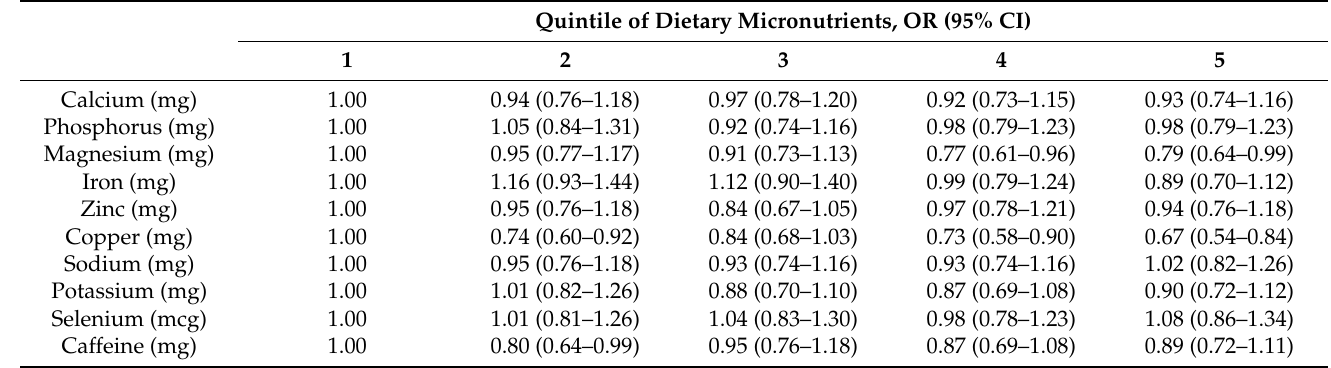
Table 6. Univariate logistic regression analysis of the association of dietary micronutrients with self-reported eye affliction/retinopathy in individuals with